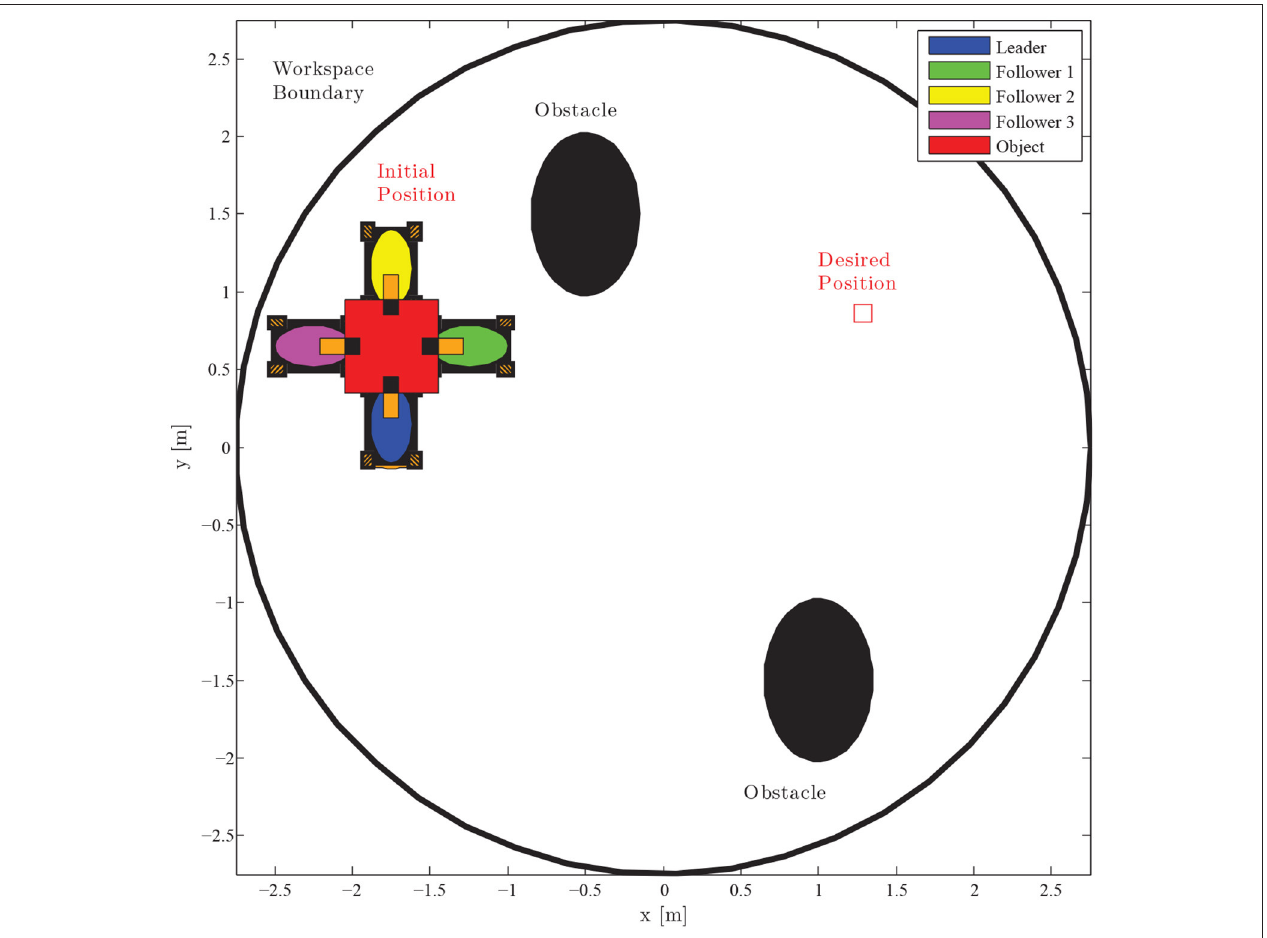
FIGURE 5 | Four mobile manipulators handling a rigidly grasped object in a constrained workspace with static obstacles. Only the leader is aware of the object’s desired configuration and the obstacles’ position in the workspace.